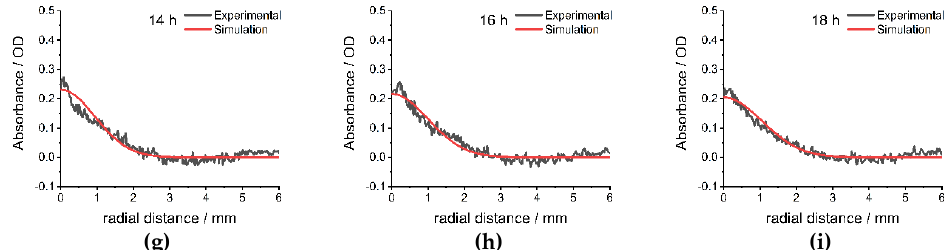
Figure 4. ( a ) Simulated absorbance profile after overlaying of large CdSe nanoparticles (d = 3.8 nm) over time; Comparison of simulated and experimental absorbance profiles after overlaying of large CdSe nanoparticles (d = 3.8 nm) after ( b ) 4 h, ( c ) 6 h, ( d ) 8 h, ( e ) 10 h, ( f ) 12 h, ( g ) 14 h, ( h ) 16 h and ( i ) 18 h at λ = 500 nm at 36 °C. Radial distance is distance from the top of the polymer melt.